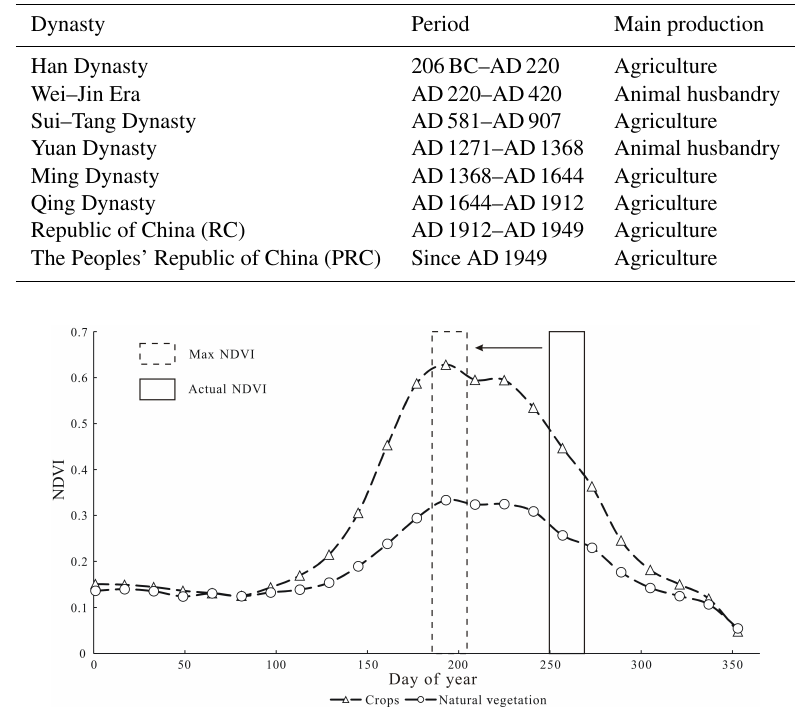
Figure 2. NDVI profile for natural vegetation and crops in 2013. The rectangles indicated the scheme of the calibrated actual Landsat NDVI (solid rectangle) to the annual maximum NDVI (dashed